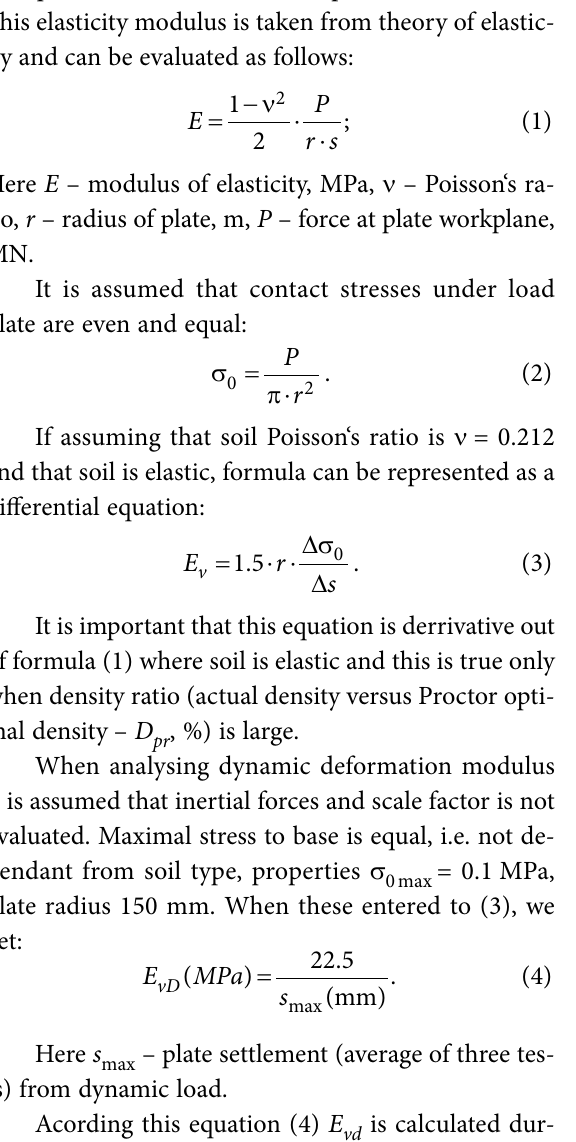
Tangent curve for Evl Tangent curve for Ev2